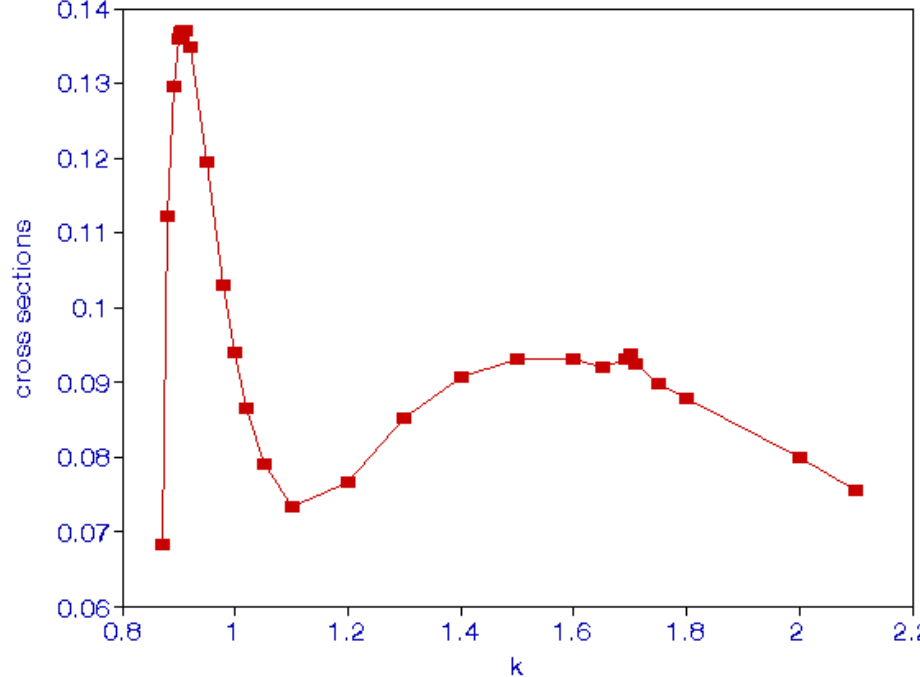
) vs. the incident momentum 0 2 a π ) vs the incident momentum k 0